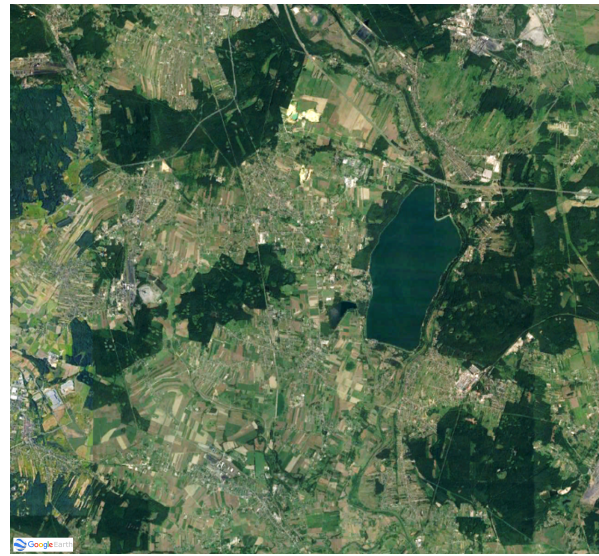
Figure 5. Underground test site (15km × 15km) owned by PGG, 60km West of Krakow, Poland. Background image captured from Google Earth. Center at (19 ◦ 12 (cid:48) 0 . 27 (cid:48)(cid:48) E, 50 ◦ 7 (cid:48) 53 . 14 (cid:48)(cid:48) N) (© Google Earth).